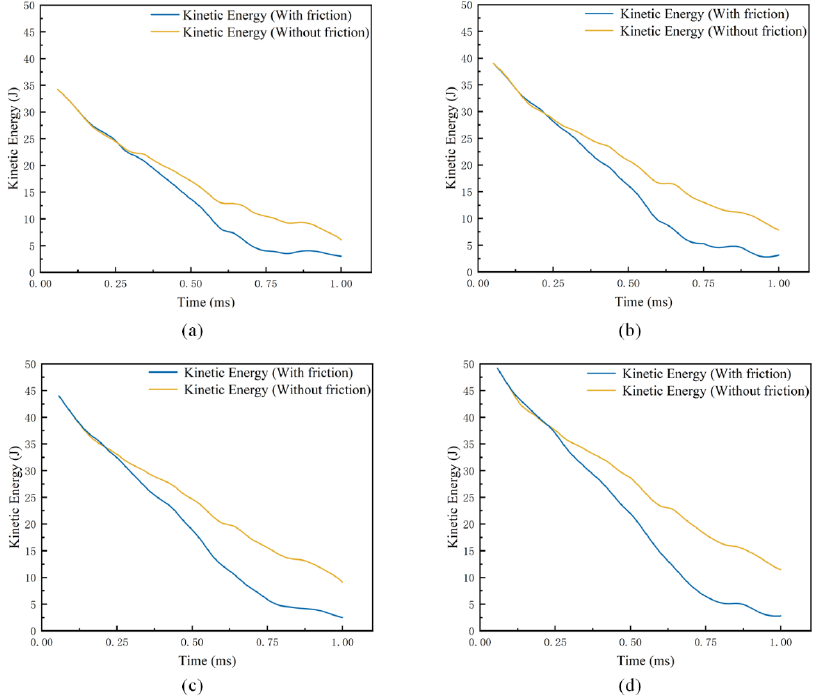
Figure 9. Kinetic energy evolution curve. ( a ) Evolution of kinetic energy at a velocity of 37.5m/s; ( b ) Evolution of kinetic energy at a velocity of 40m/s; ( c ) Evolution of kinetic energy at a velocity of 42.5m/s; ( d ) Evolution of kinetic energy at a velocity of 45m/s .